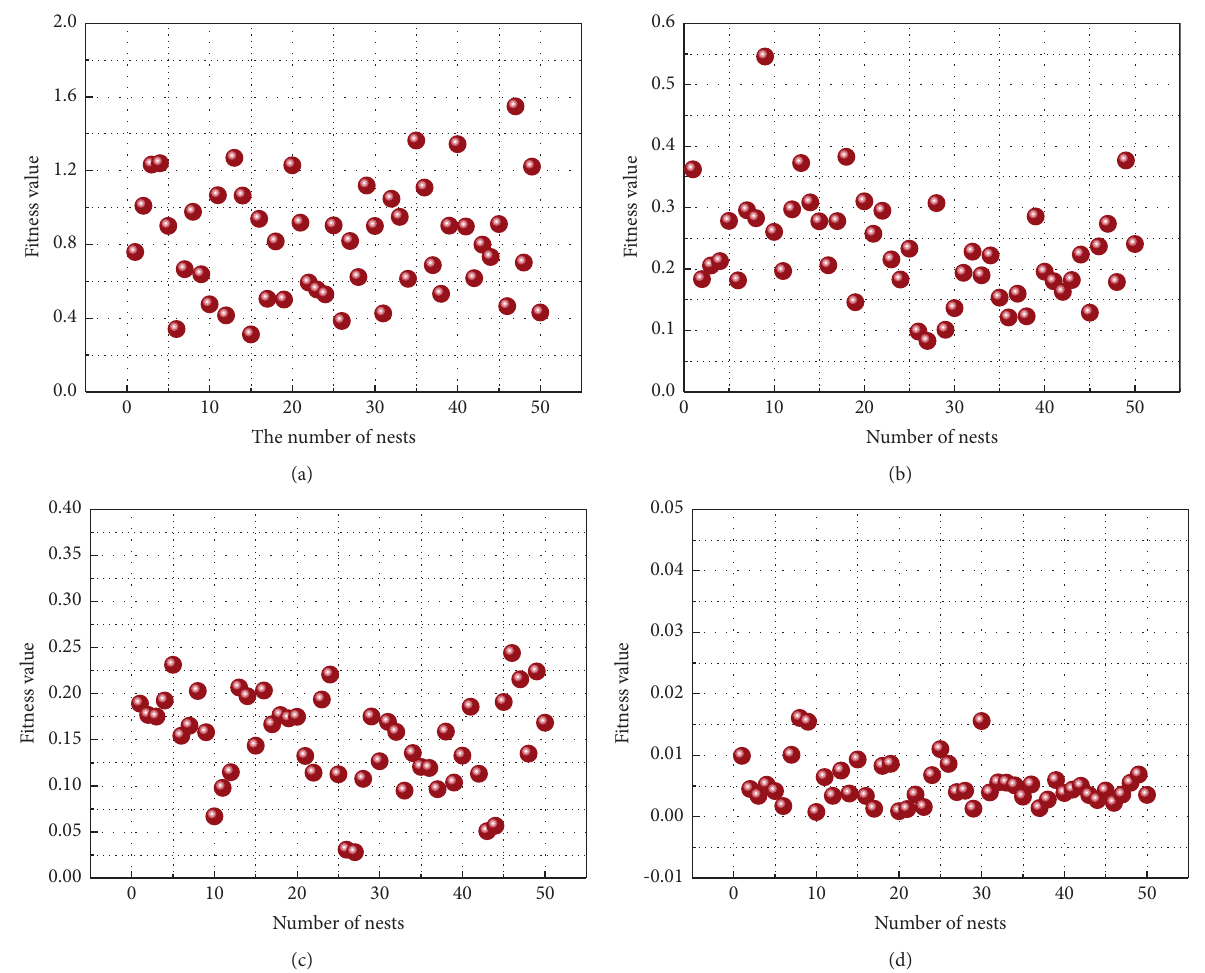
Figure 5: Fitness values of iterative process. (a) 1st; (b) 5th; (c) 15th; (d)